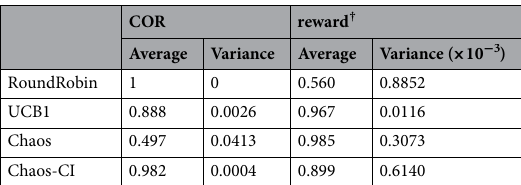
Table 1. Sample average and variance of metrics over 100 reward environments.( n = 10,000